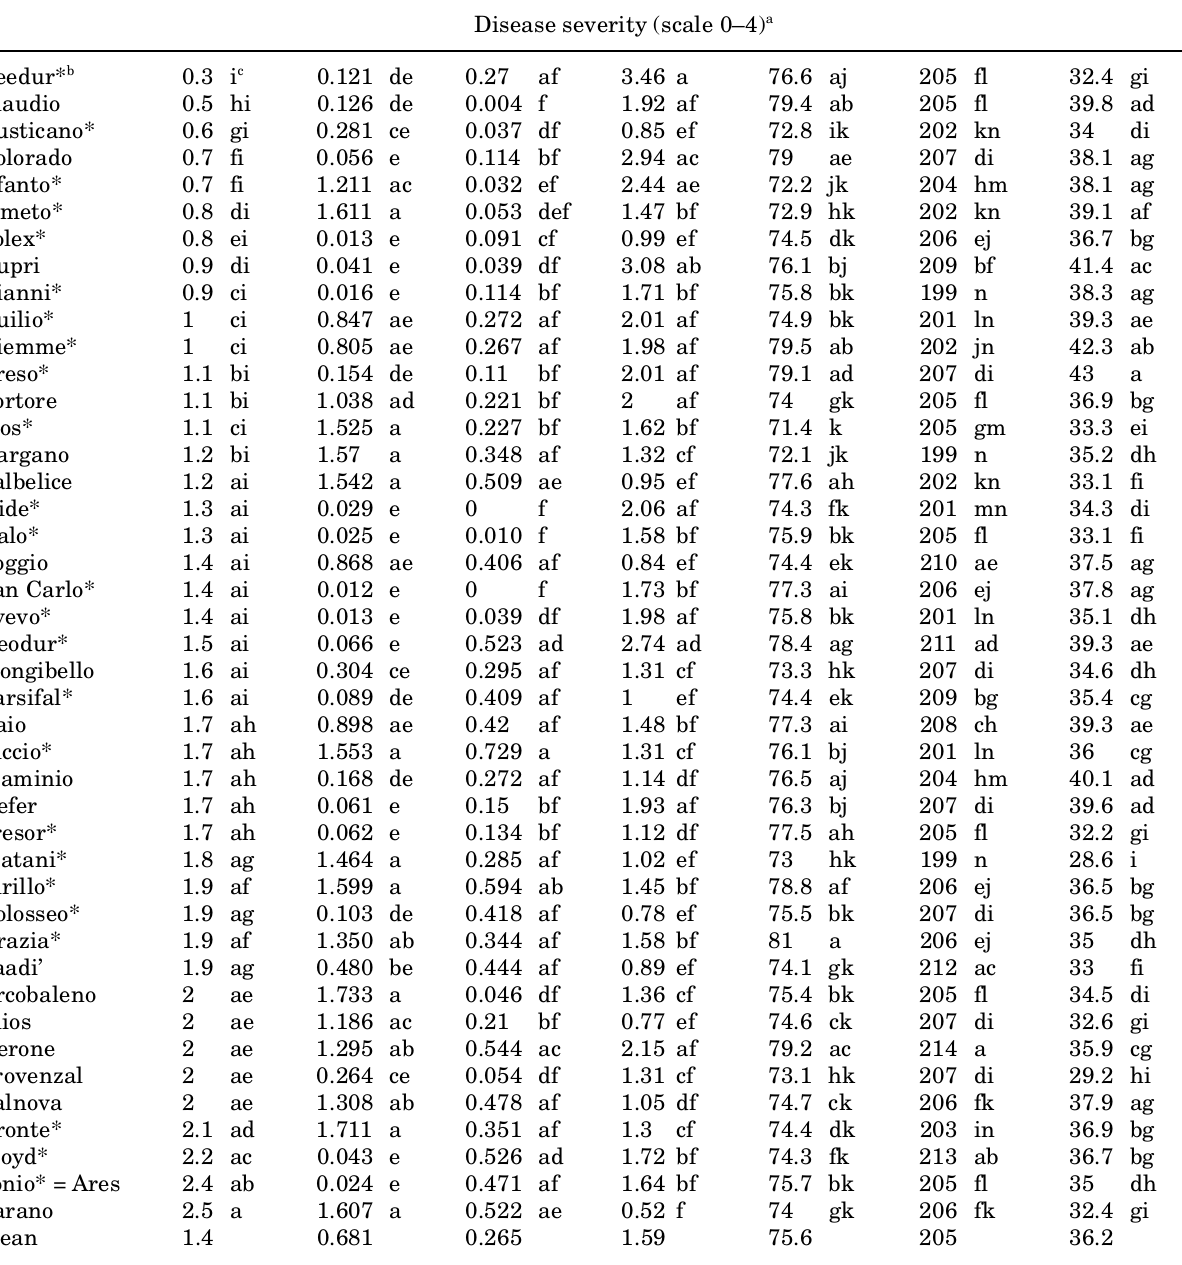
Table 1. Symptom severity, ELISA values, grain yield, test weight, days to head and thousand-kernel weight for 43 cultivars of durum wheat grown in a field infected with both SBWMV and WSSMV near Rome, Italy, during